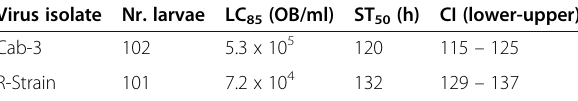
Table 2 Kaplan-Meier estimation of ST 50 for Spodoptera littoralis larvae infected with OBs derived from two SpliNPV strains in a single